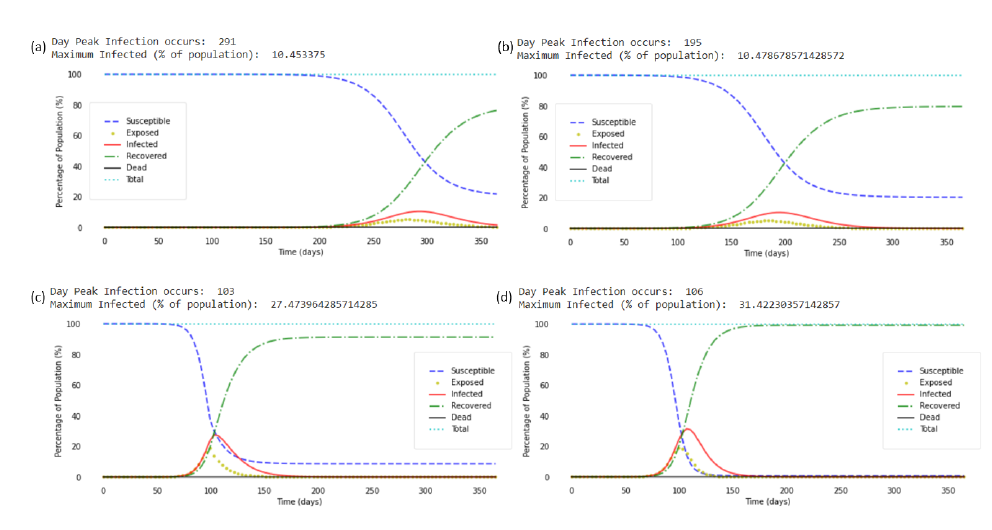
Figure 3. SEIR Plots for delays of ( a ) 0 days, ( b ) 50 days, ( c ) 100 days. ( d ) corresponds to the control case where mask wearing is not enforced.